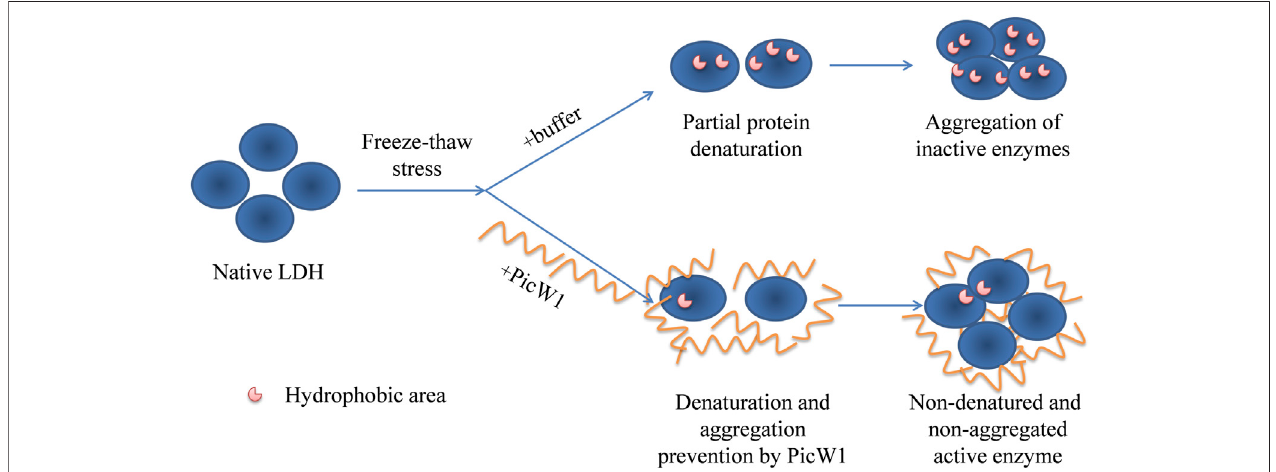
FIGURE6| PutativemechanismsforcryoprotectiveactivityofPicW1.WhenLDHisfrozenandthawed,hydrophobicpatchesappearonthesurfaceoftheproteins, and then hydrophobic interaction is generated between the patches. PicW1 acts as a shielding molecule to interfere with the hydrophobic interaction between LDHs. Finally, LDH maintains a more natural